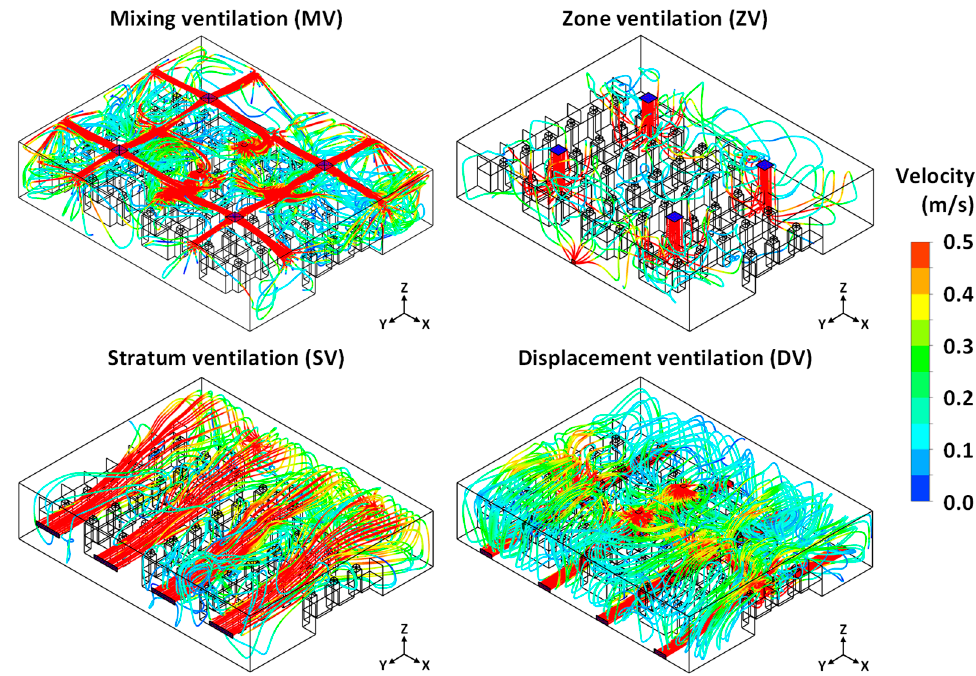
Figure 4. Streamline distribution of different ventilation modes in the office, including mixing ventilation (MV), zone ventilation (ZV), stratum ventilation (SV) and displacement ventilation